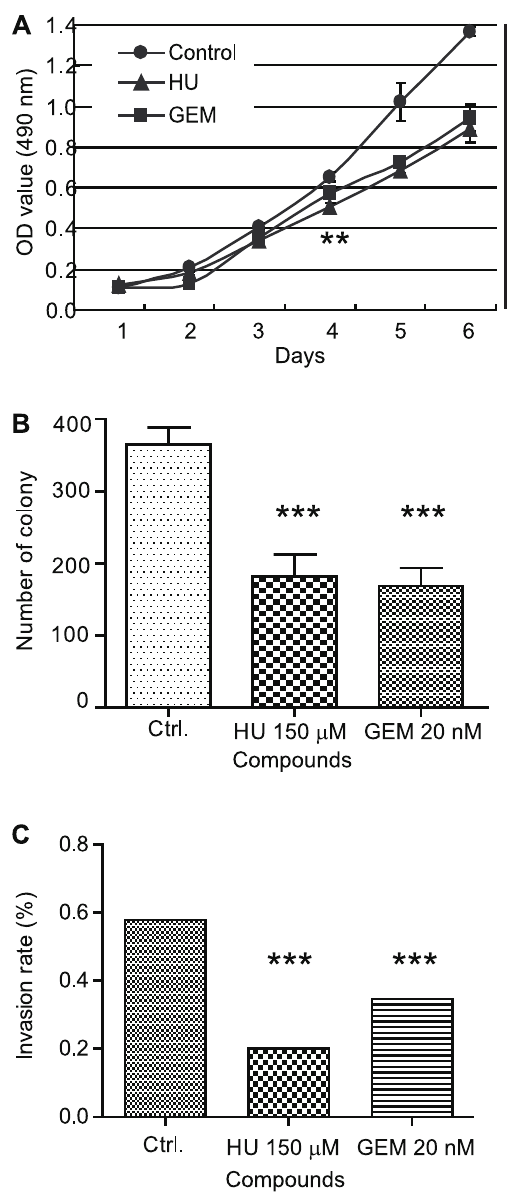
Figure 7. Treatment with HU or GEM decreases the malignancy of UACC-1598 ovarian cancer cells. A. The growth of UACC-1598 cells is decreased when grown in the presence of HU or GEM. The OD value of cells were measured every day for 6 days and plotted as mean 6 SD. **denotes a P value of 0.001 to 0.01 from day 4 onwards when compared to the control group. B. Colony formation of UACC-1598 cells is decreased when grown in the presence of HU or GEM. The average numbers of colonies 6 SD decreased from 365 6 24 colonies to 182 6 30 for HU treated cells and 168 6 25 for GEM treated cells. ***denotes a P value of , 0.001 when compared to the control group. C. One representative trial of cell invasion is plotted for Ctrl., HU treated, and GEM treated cells. The invasion percentage of cells decreased from 0.58% for control group to 0.20% for HU treated cells and 0.35% for GEM treated cells. ***denotes a P value of , 0.001 when compared to the control group.